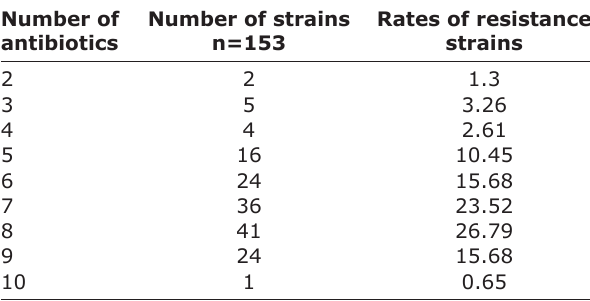
Table-2: Strains of Escherichia coli showing multidrug resistance.